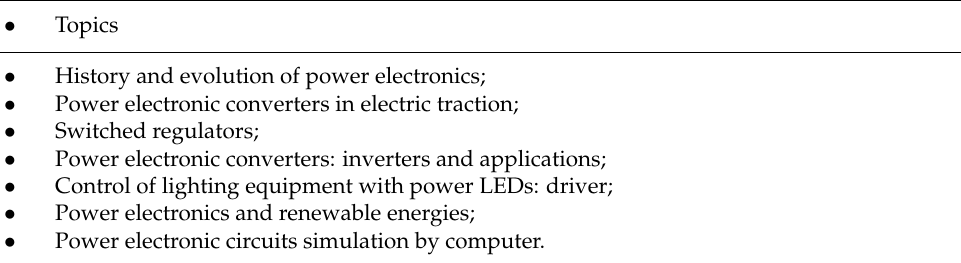
Table 3. Description of the recommended digital tools for content curation.